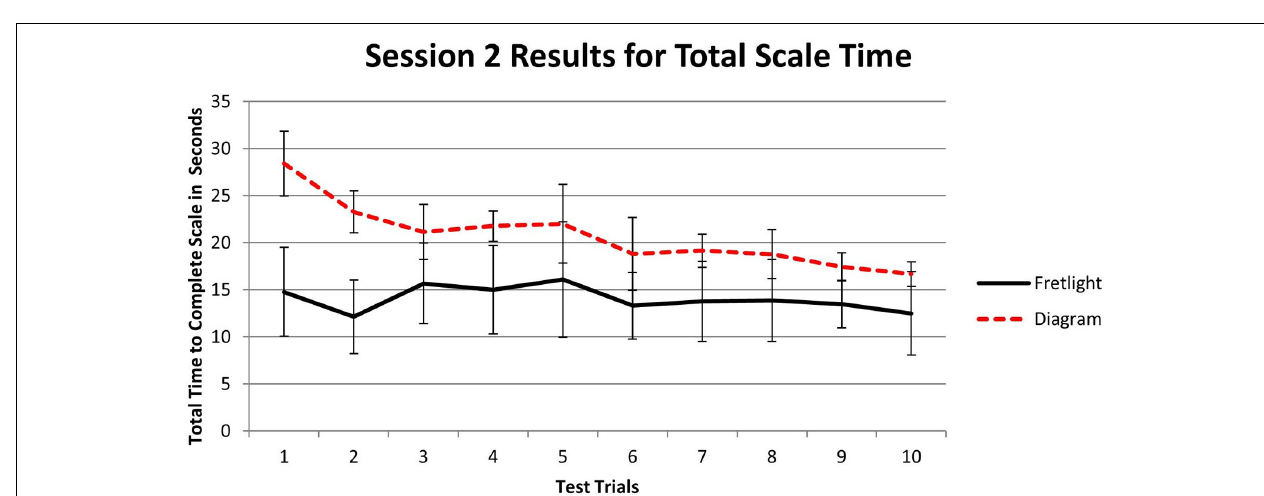
FIGURE 12 | Time to complete each test trial by learning method after